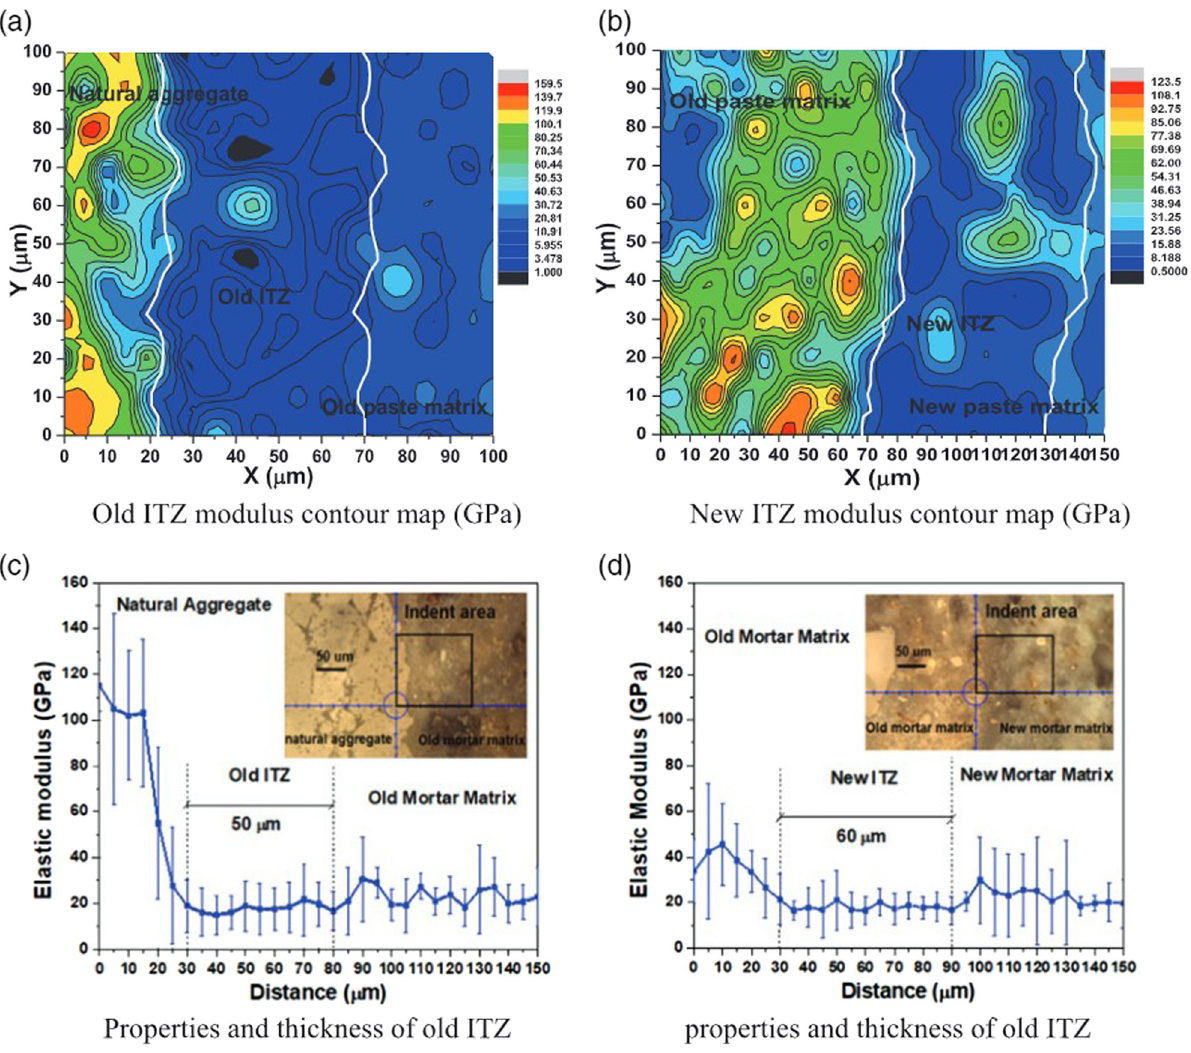
Figure 6: Elastic modulus distribution of old and new ITZ in RAC [ 67 ] . ( a ) Old ITZ modulus contour map ( GPa ) , ( b ) new ITZ modulus contour map ( GPa ) , ( c ) properties and thickness of old ITZ, and ( d ) properties and thickness of old